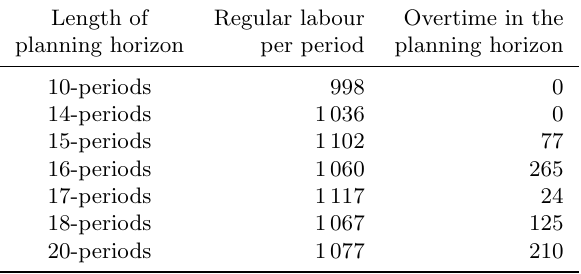
Table 5: Regular and overtime labour used for different planning horizons.